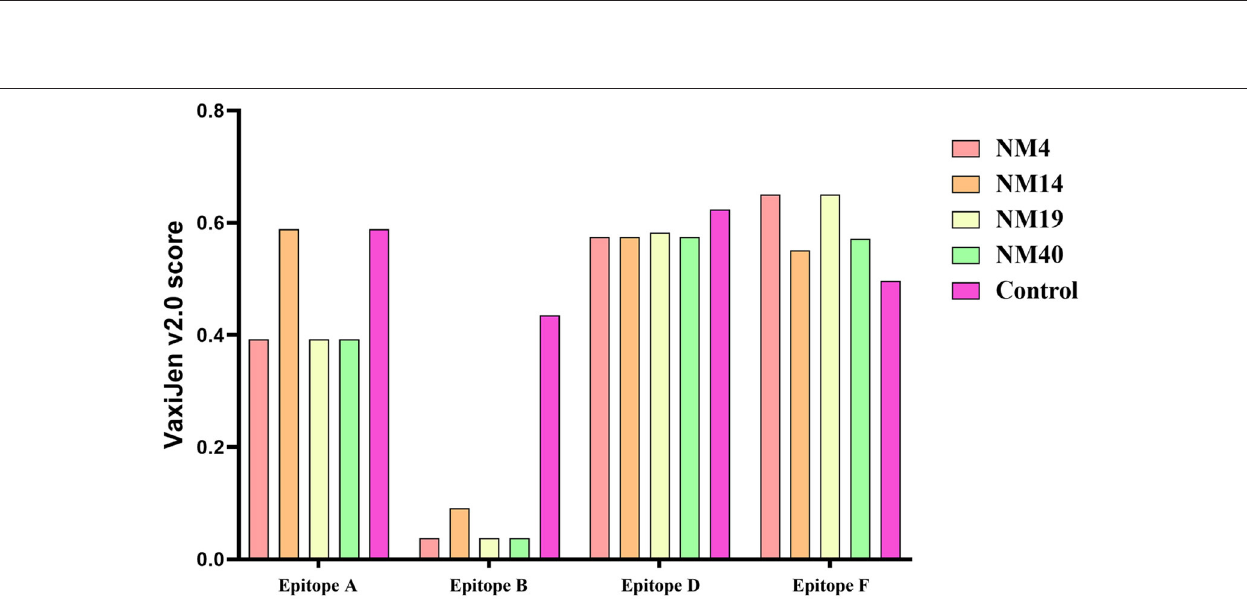
Frontiers in Veterinary Science |